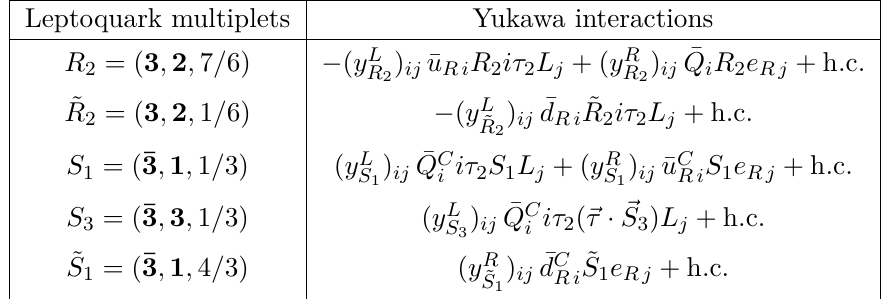
Table 1 . Scalar leptoquark multiplets and their interactions with the SM quark-lepton